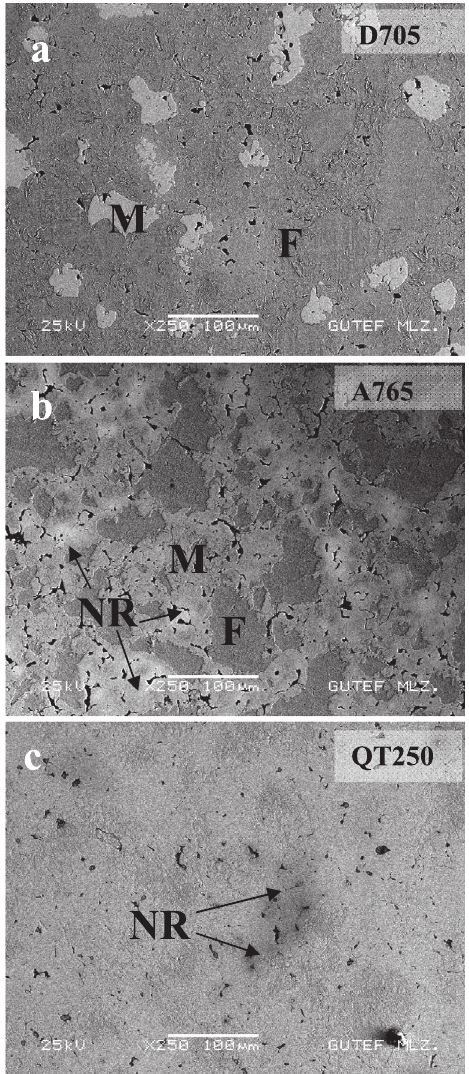
Fig. 1: SEM micrographs of the D705 (a) and A765 (b) specimens with ferrite plus martensite microstructure and of the QT250 (c) specimen with fully tempered martensitic microstructure (F: ferrite; M: martensite; NR: nickel